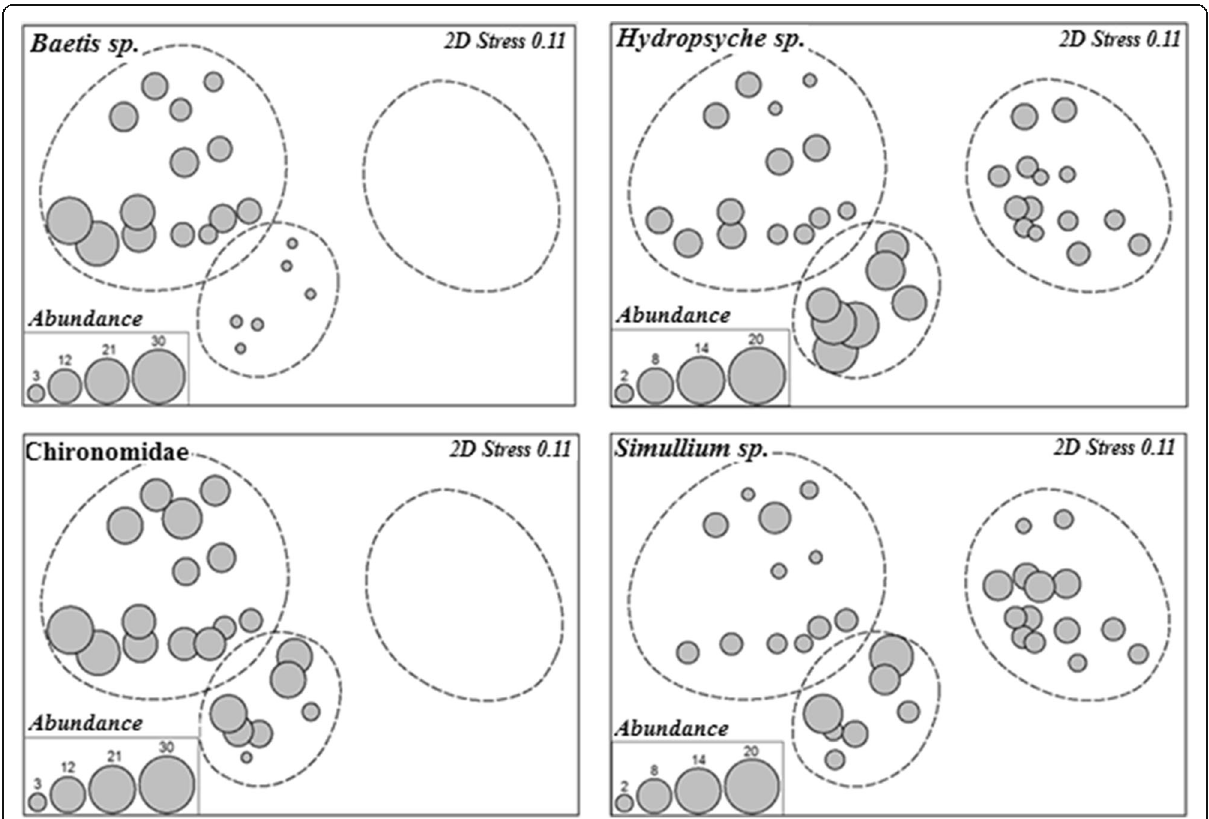
Fig. 7 Bubble plots displaying an abundance of four taxa imposed on the nonmetric multidimensional scaling ordination (nMDS). Circles represent ≥ 37% similarity between